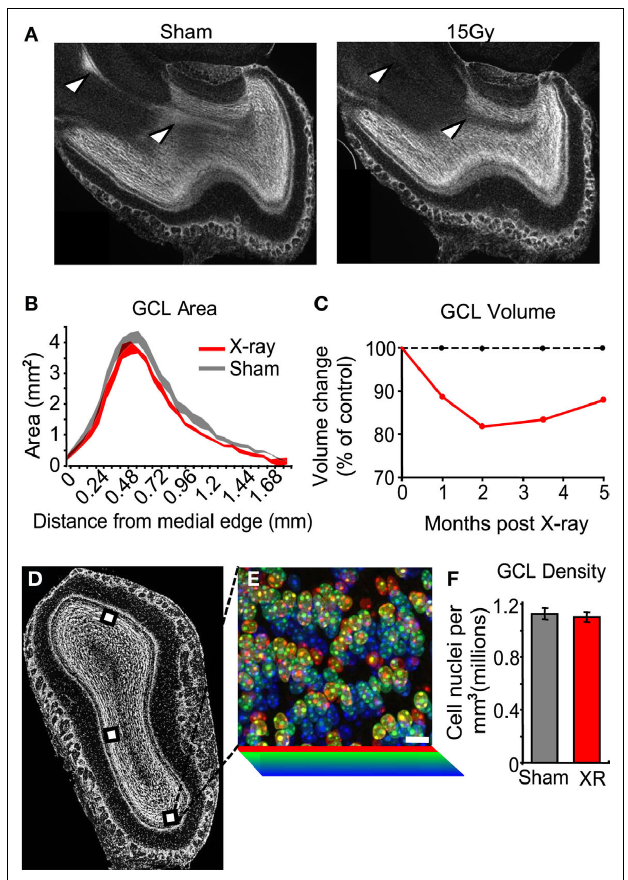
FIGURE 3 | The number of cells in the granule cell layer is reduced following irradiation. (A) Sagittal sections of sham (left) and irradiated tissue (right). Sectioning the entire medial-lateral extent of the olfactory bulb followed by DAPI staining allowed surface area measurement of serial planes along the volume of interest. The rostral migratory stream is indicated by arrows, and is present in sham-treated tissue (left) but nearly absent in irradiated tissue (right). (B) Cross-sectional area of the granule cell layer for data grouped across all time points. (C) The volume encompassed by the edge of the GCL declined in the x-rayed condition (solid red line) compared to controls (dotted line) between 1 and 5 months after irradiation (values represent group means, for statistics see Table 1 ). (D) Example density counting windows placed in an irradiated GCL. (E) Implementation of the optical disector to estimate cell density from high- magnifi cation z -stacks of GCL nuclei false-colored according to z -depth, scale = 10 um. (F) Density of granule cell layer from mice receiving sham treatment (grey), and irradiation (red). This data represents the average of multiple anatomical regions, and durations between 1 and 5 months after irradiation. We observed no trend in density over time. All error bars indicate SEM.